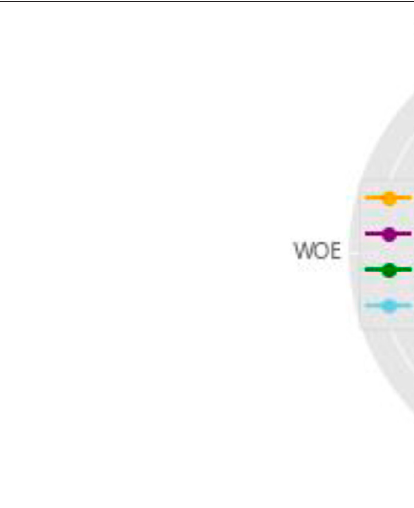
FIGURE 10 | Comparison of average accuracy of power